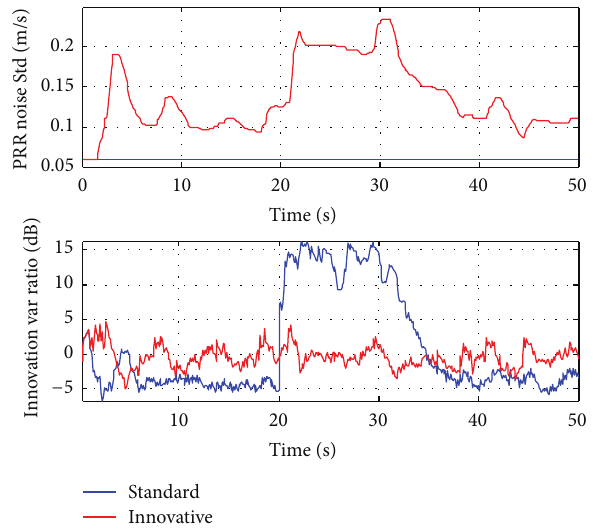
Figure 9: 𝐶/𝑁 0 and adapted bandwidth.